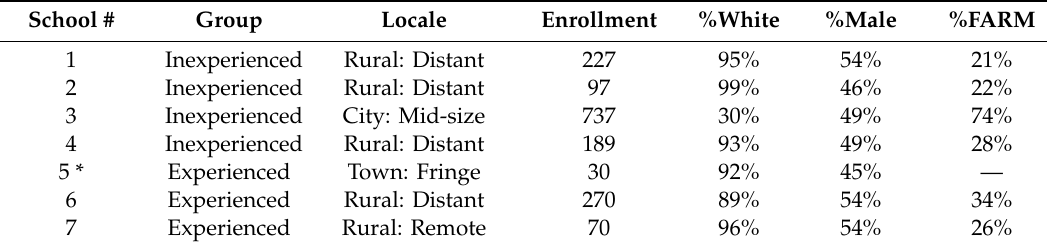
Table 1. Characteristics of the Inexperienced and Experienced Schools.